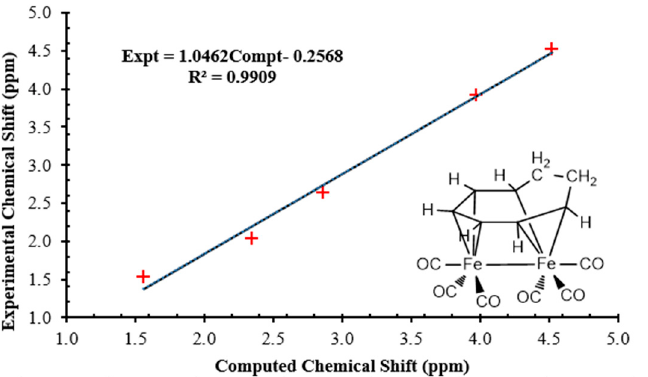
Figure 5. Linear fitting between the computed gas phase proton chemical shifts and experimental 1 H NMR of (C 8 H 10 )Fe 2 (CO) 6 .